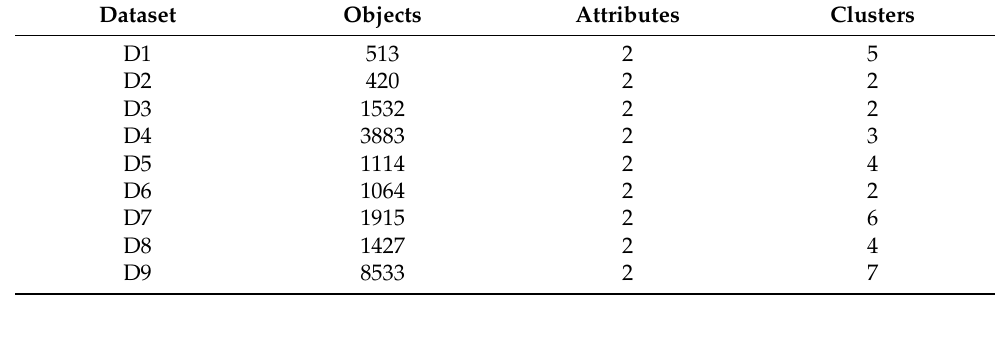
Table 1. The basic information of the nine synthetic data sets.